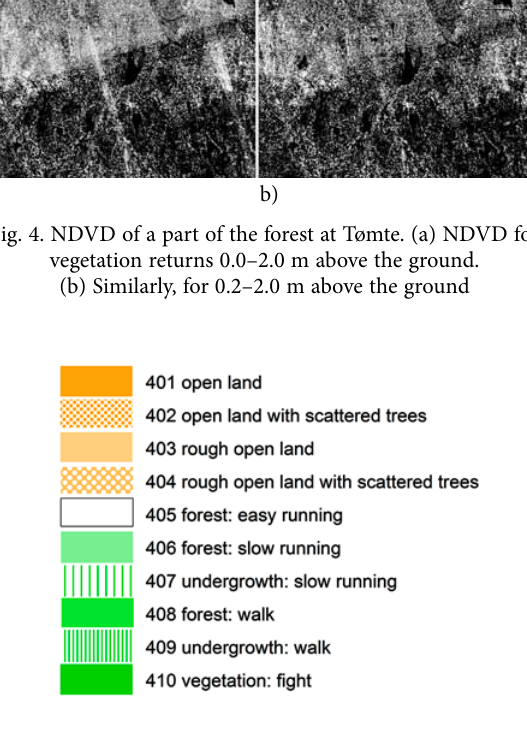
Fig. 5. Legend for vegetation